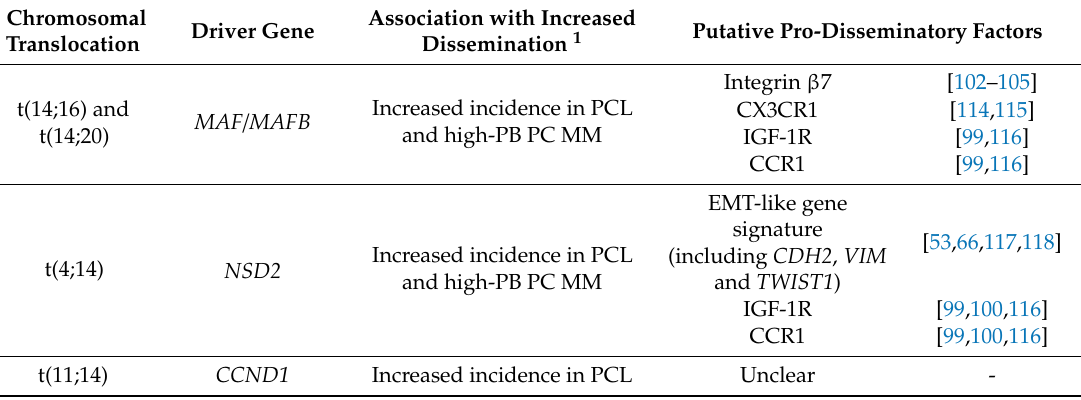
Table 2. Chromosomal translocations associated with increased dissemination in multiple myeloma (MM) and plasma cell leukaemia